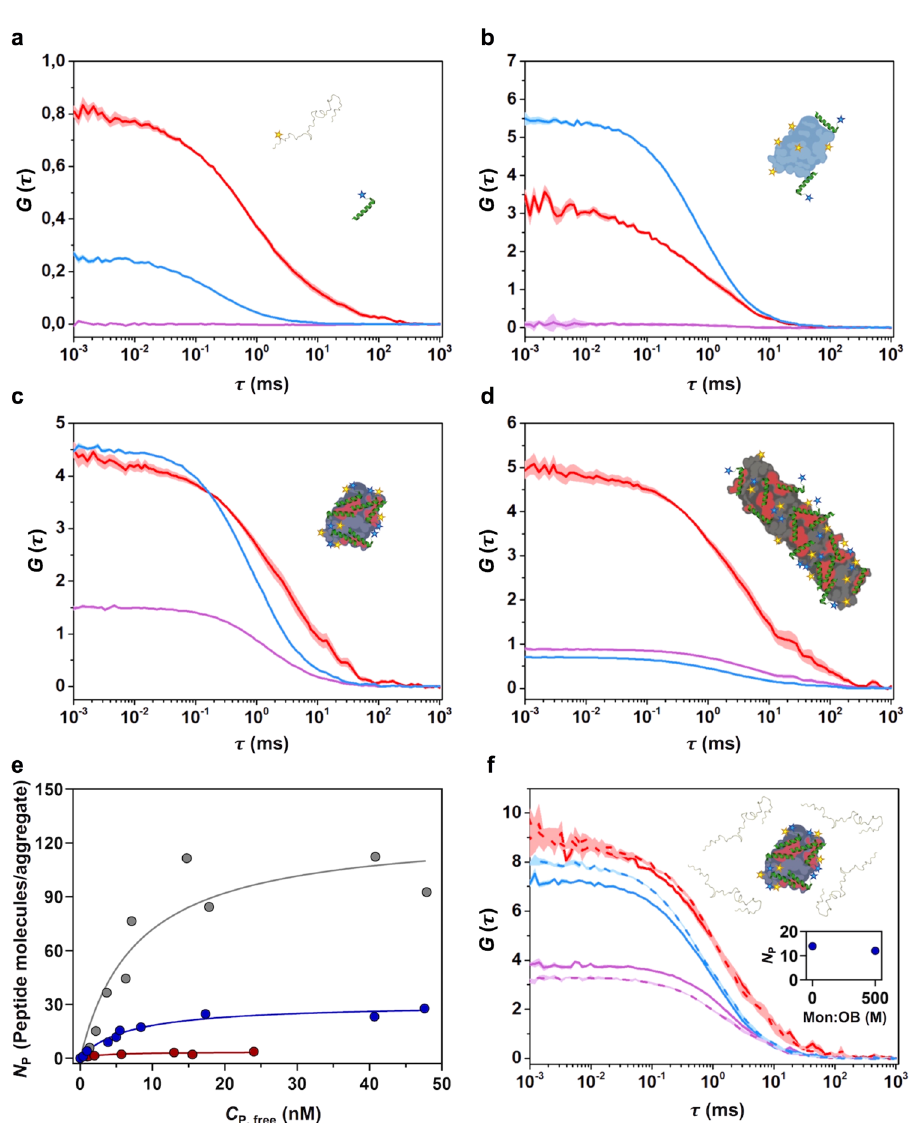
Fig. 2 Interaction of PSM α 3 with different α S species by dcFCCS. a – d Representative auto-correlation curves for α -synuclein ( α S) (blue line) and PSM α 3 (red line) and cross-correlation curves for interacting molecules (purple line). The amplitude (G) error is shown as faint colored area for the corresponding correlation curves. Samples contained ( a ) ~15 nM α S monomer and ~15 nM PSM α 3, ( b ) 1 nM type A* and ~5 nM PSM α 3, ( c ) 1 nM type B* oligomers and ~5 nM PSM α 3 or ( d ) ~5 nM sonicated fi brils and ~5 nM PSM α 3. e Titration binding curves for the interaction of PSM α 3 with type A* oligomers (red circles), type B* oligomers (blue circles) or sonicated fi brils (gray circles) obtained by dcFCCS, showing their corresponding analysis assuming a model of n identical and independent binding sites (referred in equation 7 as N max ) per α S aggregated species (solid lines). N P represents the number of bound peptides per aggregate. f Auto-correlation curves ( α S in blue, PSM α 3 peptide in red) and cross-correlation curve for the interacting molecules (in purple) obtained in samples containing ~1 nM α S type B* oligomers and ~2 nM PSM α 3 in the absence (solid lines) or presence (dashed lines) of a 500-molar excess of unlabeled monomer with respect to the particle concentration of oligomers. The inset shows the number of bound peptides ( N P ) per aggregate in both conditions. For α S aggregated species, each consisting of several tens of monomers, the species concentrations are in the picomolar range and, as further explained above, single-particle conditions are ensured throughout the